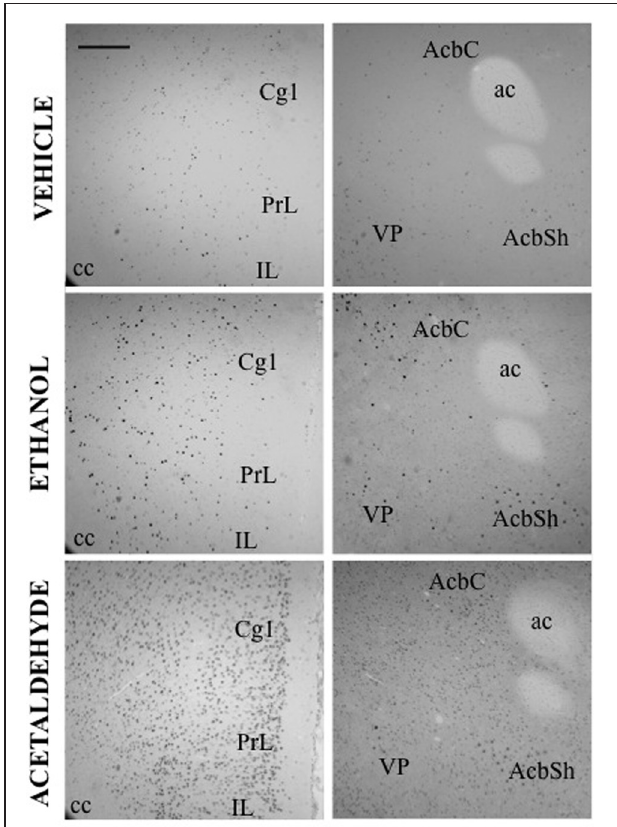
FIGURE 2 | c-Fos induction after IP administration of saline, ethanol (0.5g/kg) and acetaldehyde (0.5g/kg). Low power images (10 × ) showing PFC (left column) and Acb (right column). Scale bar = 100 µ m. ac, anterior commissure; cc, corpus